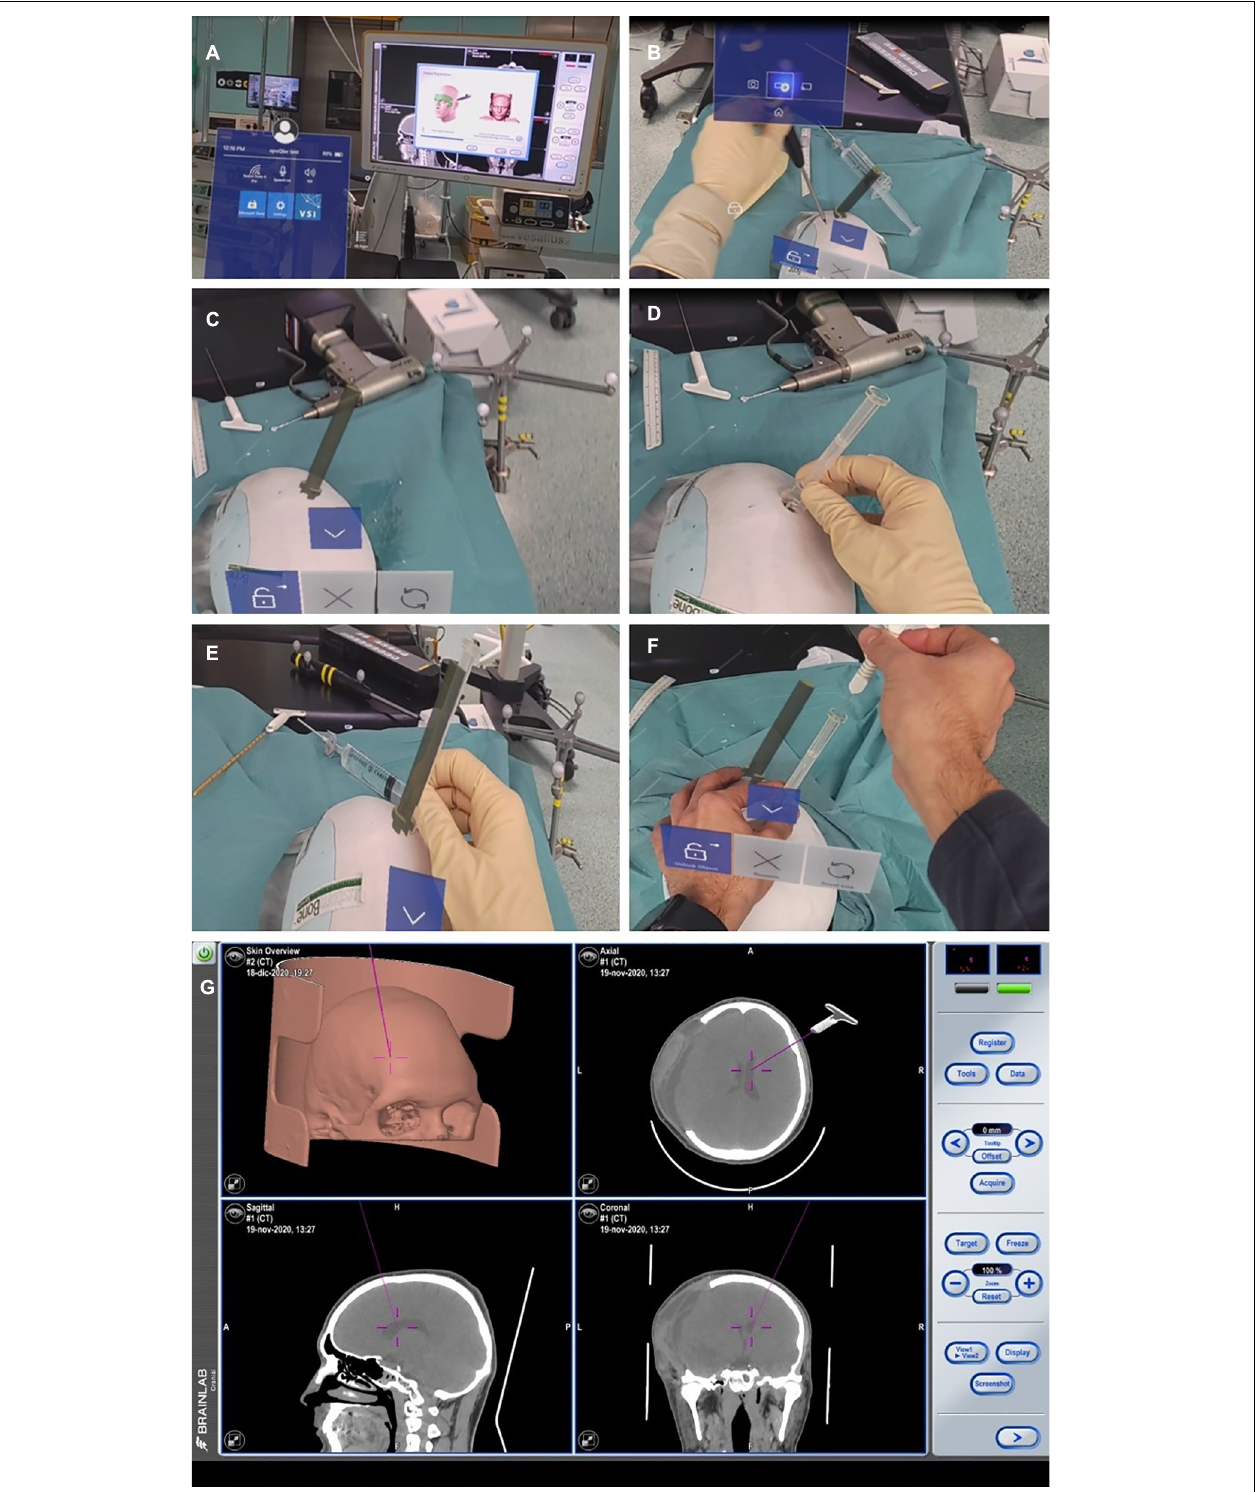
FIGURE 5 | Finceramica plaster model navigation after merging the patient’s CT scan (already treated for post-traumatic craniotomy, but with no midline shift). (A,B) Superficial tracing for navigation registration (BrainLab) of the plaster model. (C) Entry point definition with a holographic representation of the device. (D) Positioning of the real device on the defined entry point. (E) Overlap of the holographic device with the real one, to match the entry point. (F) Introduction of the navigated stylet inside the device. (G) Its representation with the standard navigation.